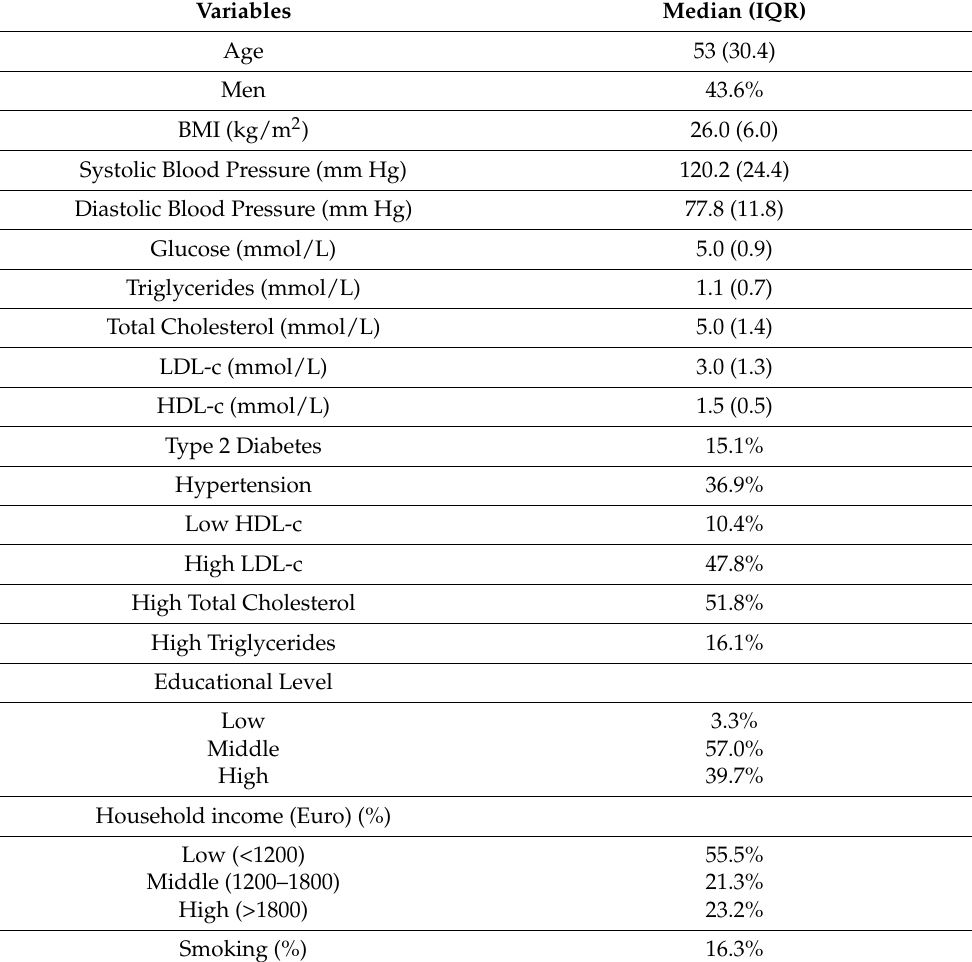
Table 1. Characteristics of the subjects ( n =